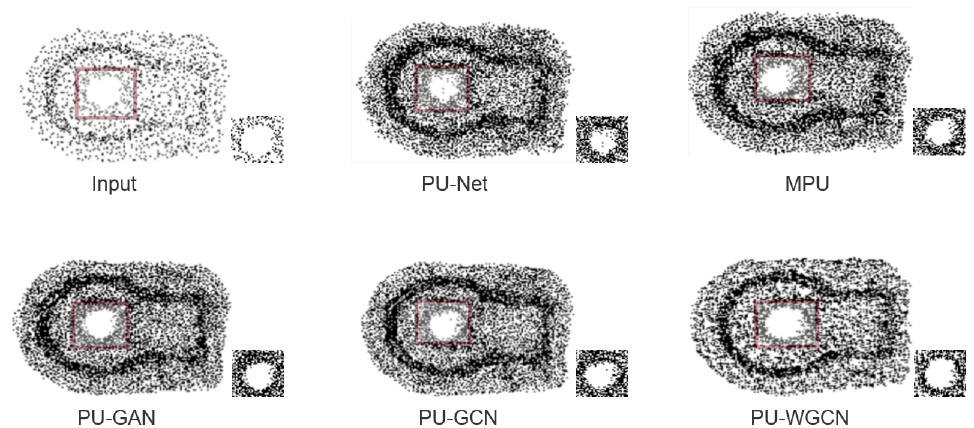
Figure 21. Robustness test by adding Gaussian noise with a variance of